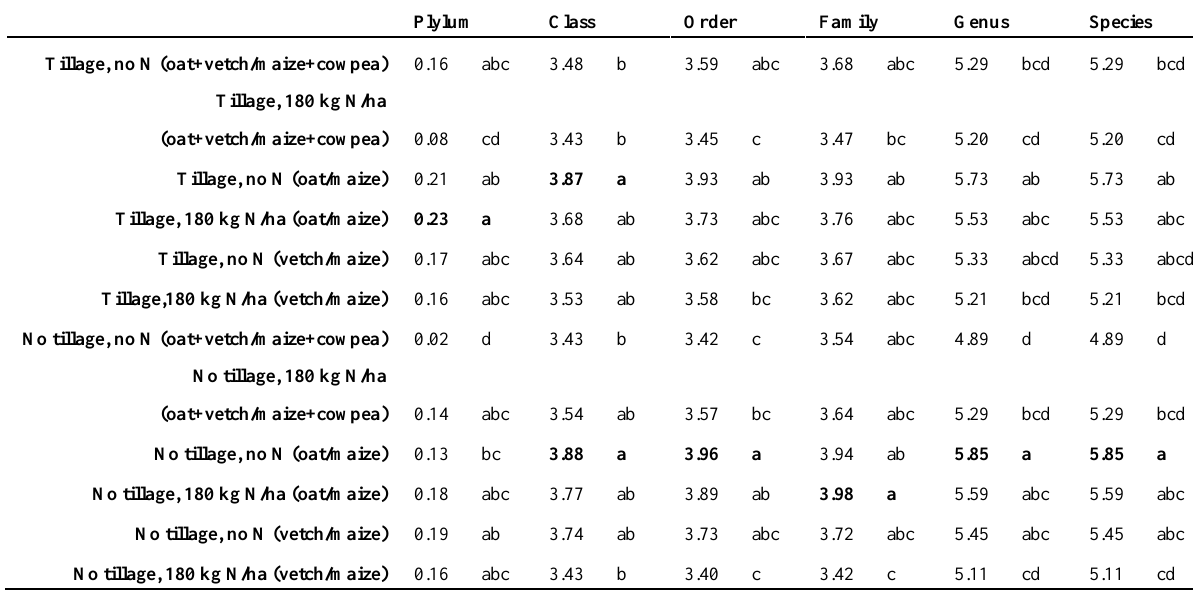
Table 1. Shannon diversity index to phylum, class, order, family, genus and species level, for each treatment. Numbers followed by the same letters on the columns, are not different by Tukey test, under p -value ≤ 0.01. The numbers in bold, indicate the highest significant SDI values from each taxonomy level.